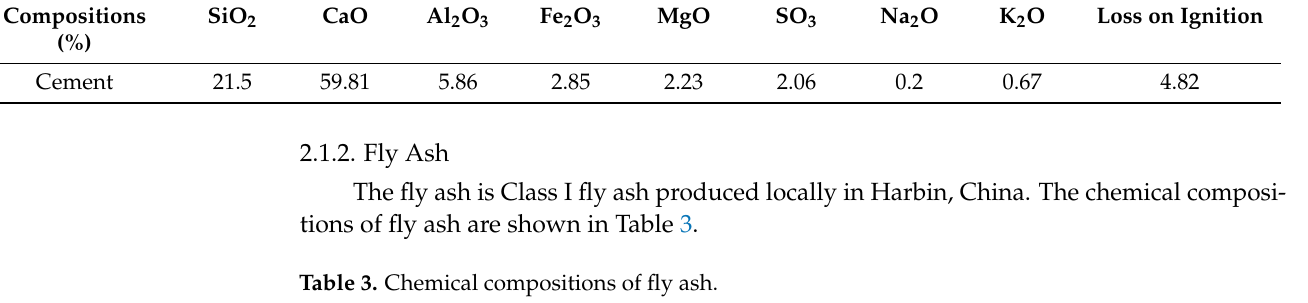
Table 3. Chemical compositions of fly